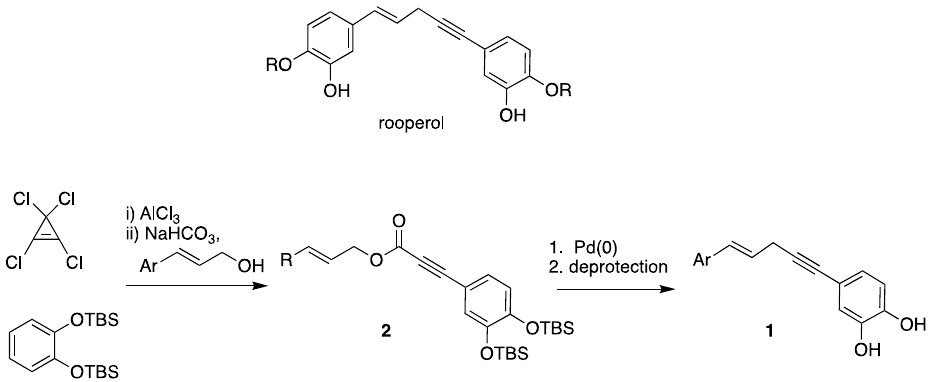
Figure 1. Structure of rooperol ( top ) and prior synthetic scheme for rooperol analogues 1 ( bottom ).